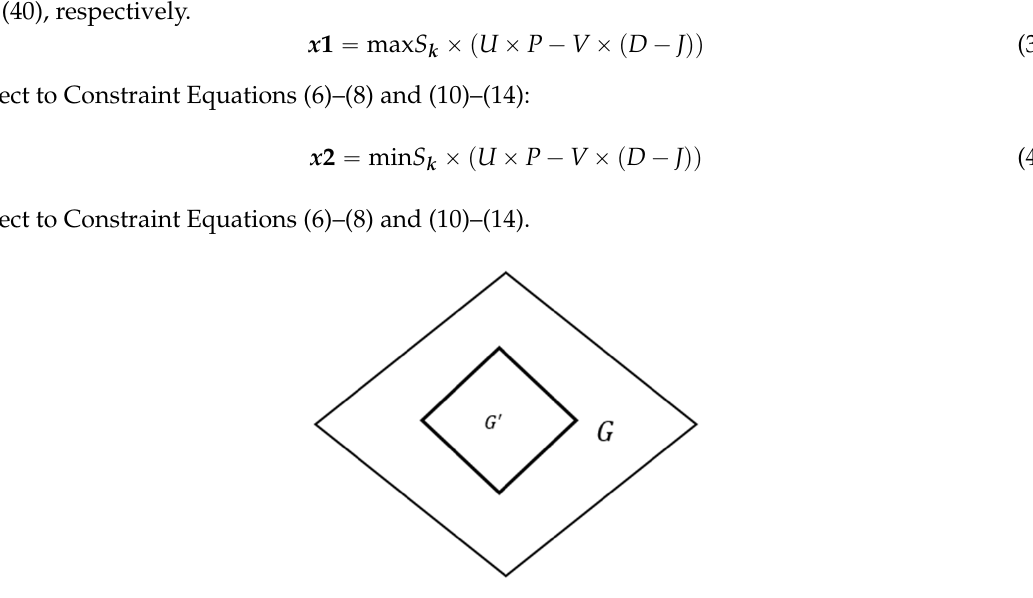
Figure 2. Feasible regions of the primary filtering phase G and the secondary filtering phase G 1 .